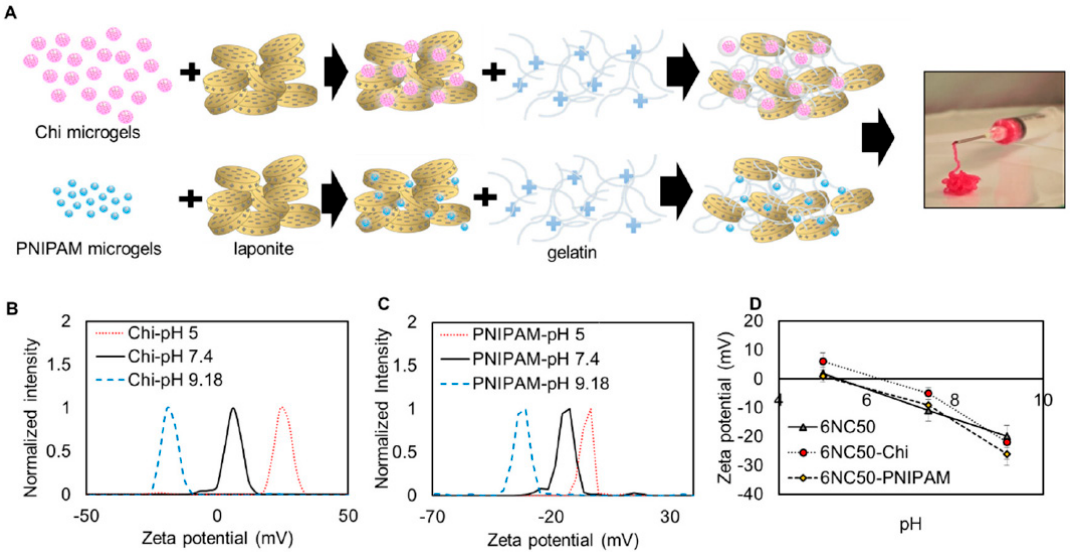
Figure 10. Electrostatic interactions between gelatin and laponite resulted in formation of pH responsive nanocomposite. ( A ) Schematic preparation of shear-thinning HG with laponite. Zeta potential at different pH of ( B ) CTS particles, ( C ) PNIPAM- co -Acrylic acid particles and ( D ) PNIPAM- co -Acrylic acid and laponite particles. Reprinted with permission from Ref. [230].